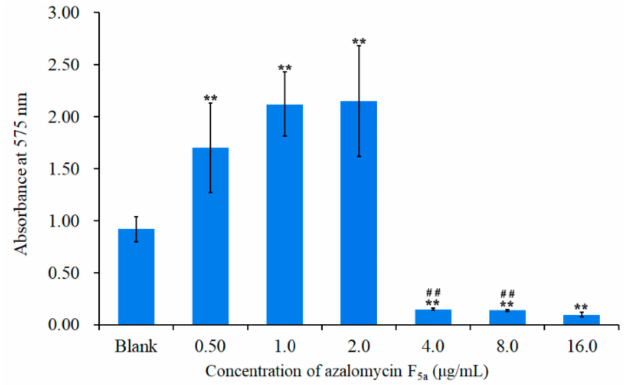
Figure 3. Influence of azalomycin F 5a on S. aureus biofilm formation. The amount of biofilm with the intervention of various azalomycin F 5a concentrations was determined using the crystal violet method; **: p < 0.01, means the groups treated with azalomycin F 5a showed a significant di ff erence comparing to the blank control; ## : p < 0.01, means the 4.0 or 8.0 µ g / mL group presents a significant di ff erence compared to the 16.0 µ g / mL